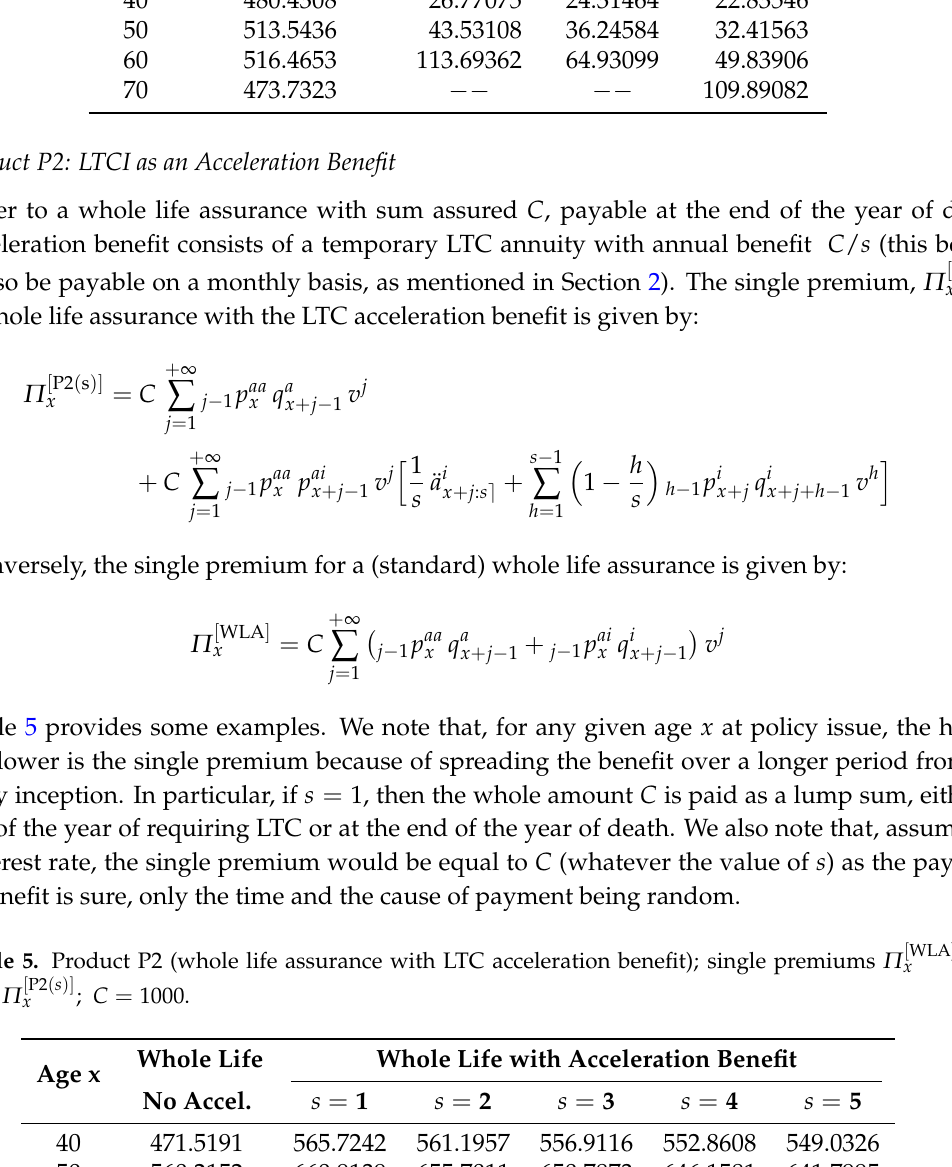
Table 4. Product P1 (stand-alone); single premium Π